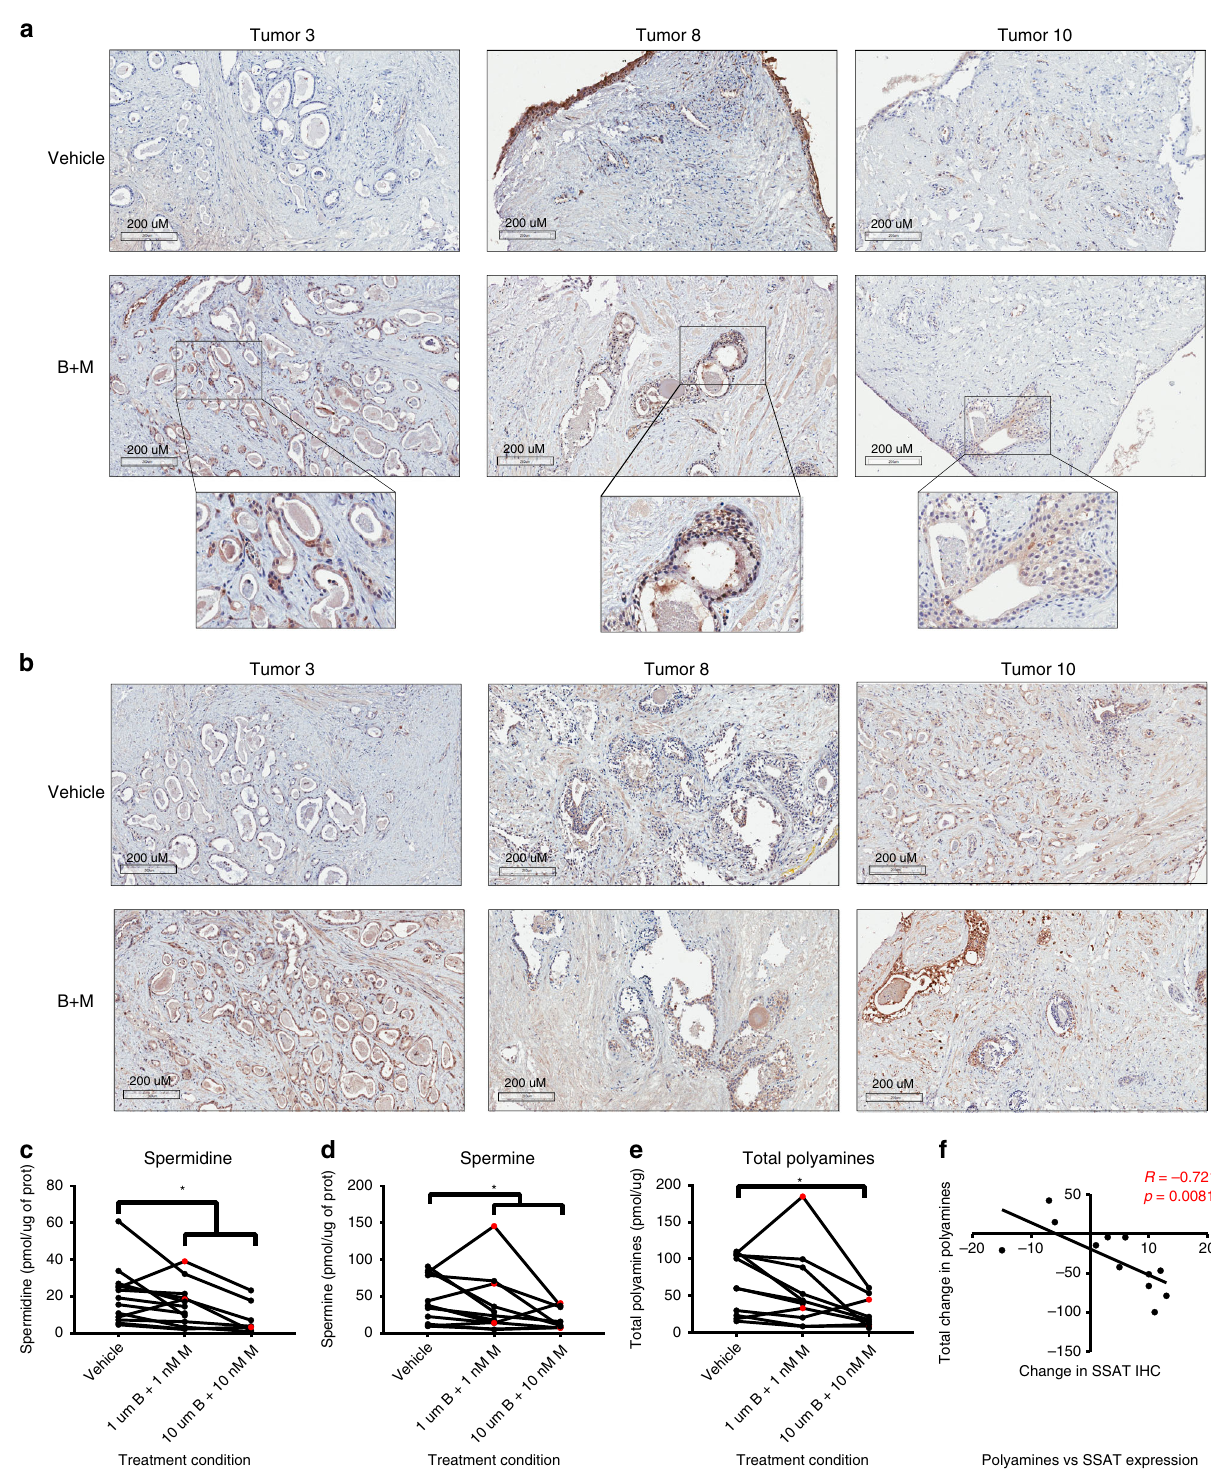
Fig. 6 BENSpm and MTDIA impact patient samples in ex vivo system. Ex vivo samples were collected from treatment naïve patients undergoing radical prostatectomy at Roswell Park Comprehensive Cancer Center. Tumors used for this study had at least 40% neoplastic involvement upon pathological review. Tumor samples were treated with vehicle control (vehicle), or combination treatment (1nM MTDIA + 1 µ M BENSpm or 10nM MTDIA + 10 µ M BENSpm) for 7 days in the presence of 20 µ M MTA. Images from representative tumors 3, 8, and 10 from immunohistochemical stained slides for a cleaved caspase-3 (CC3) or b spermidine/spermine N1-acetyltransferase (SSAT) in both vehicle and the combination treated samples (B + M. Intratumoral ( c ) spermidine (Vehicle; n